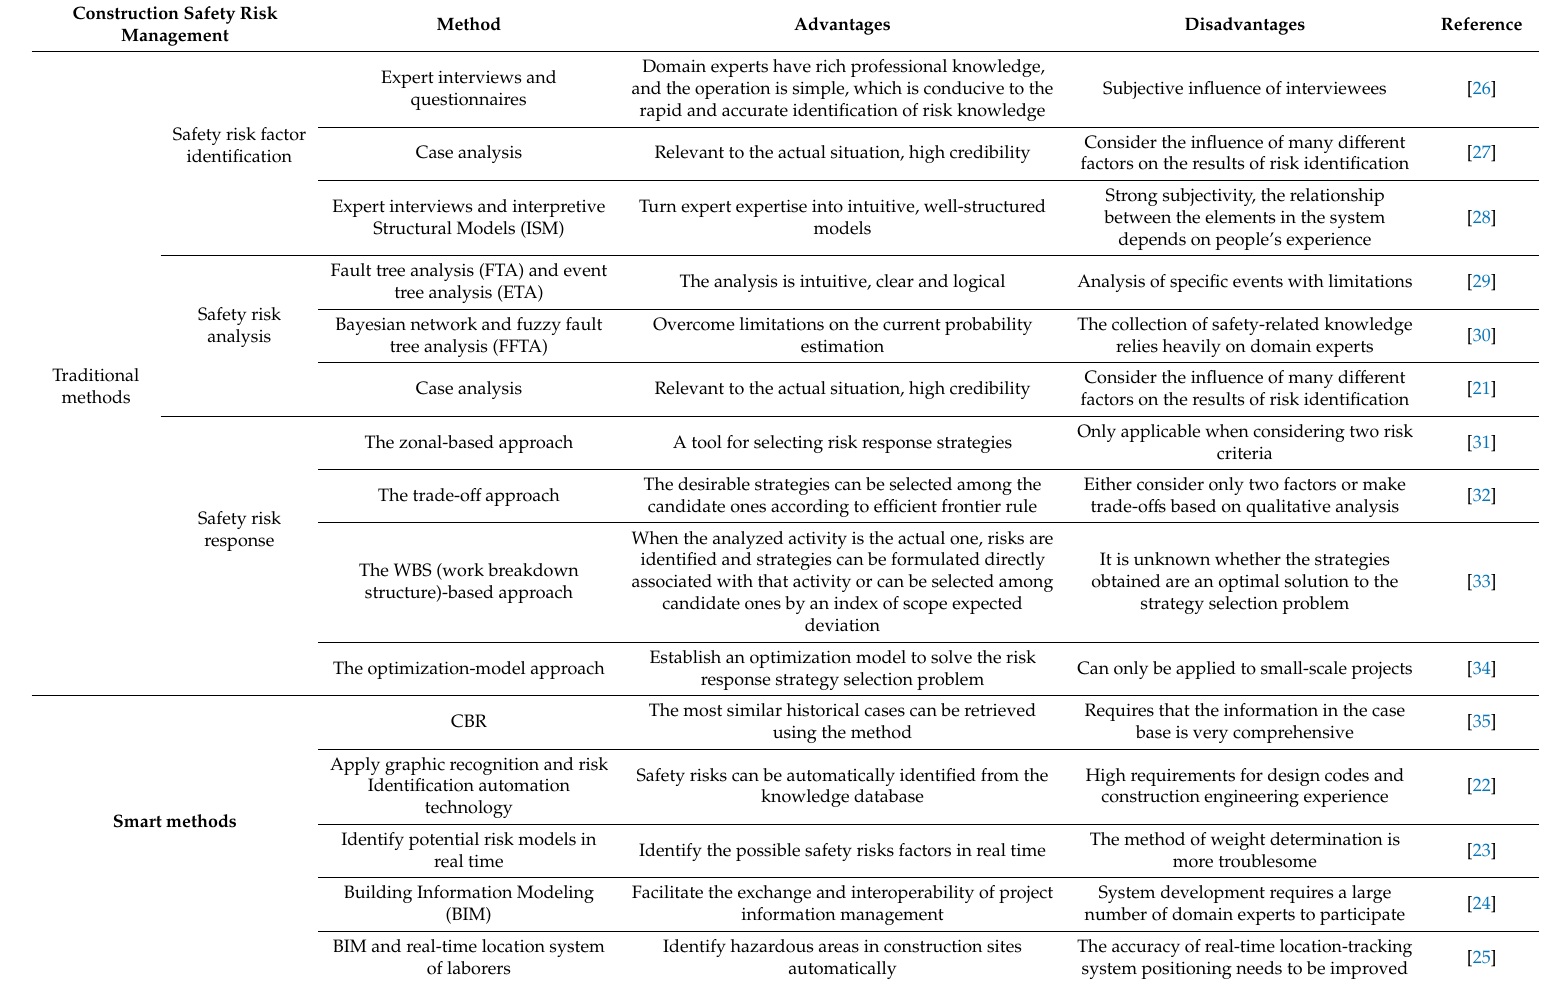
Table 1. Construction safety risk management